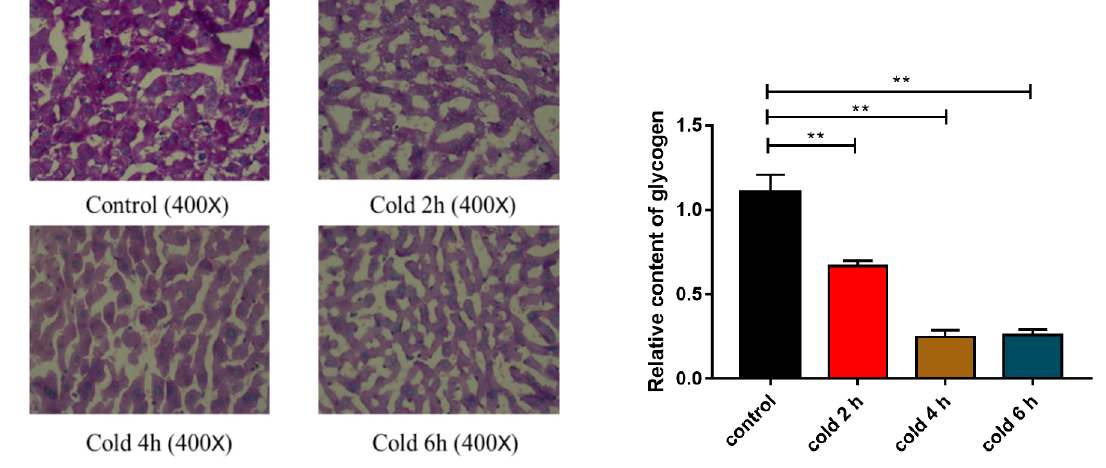
Figure 4. Effect of acute cold exposure on glycogen content in C57BL/6 mouse livers. The data are presented as the mean ± SEM ( n = 8). Statistically significant differences are indicated; * p < 0.05 and ** p < 0.01.